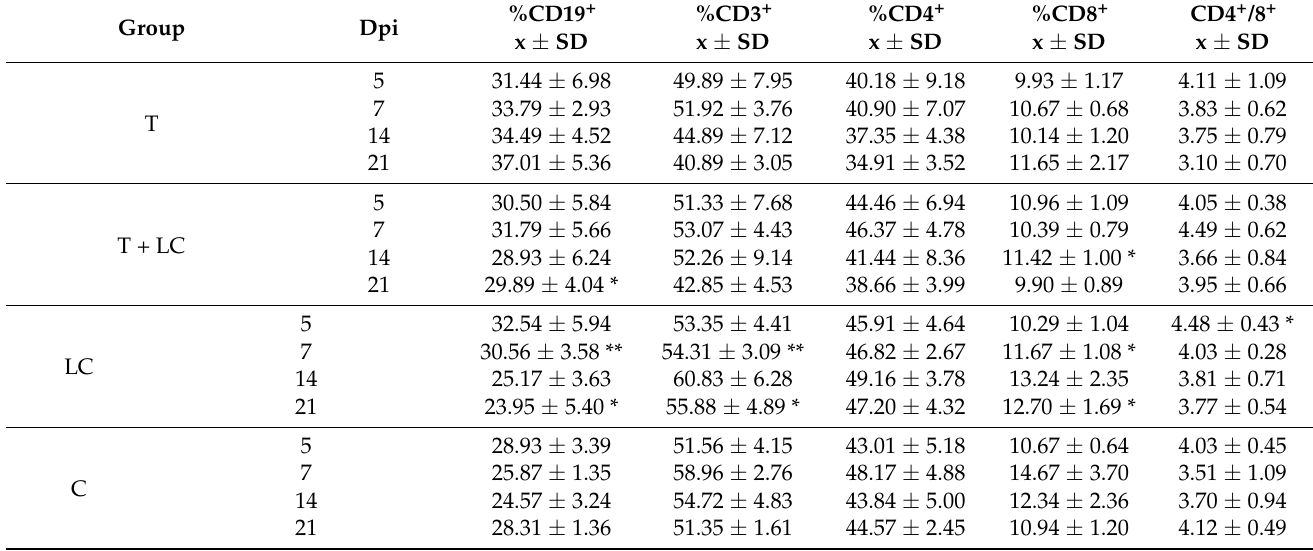
Table 5. Percentage of B (CD19 + ) and T (CD3 + , CD4 + and CD8 + ) lymphocytes in murine peripheral